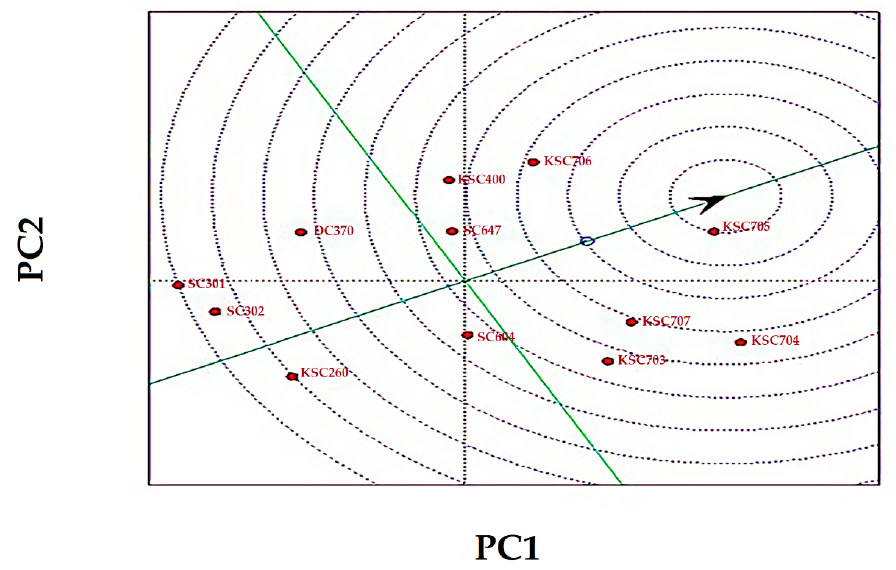
Figure 3. GGE-biplot for comparison of the maize hybrids with the ideal genotype based on grain yield and stability. (The arrow is the best point that the software determines to identify the best genotype and environments).